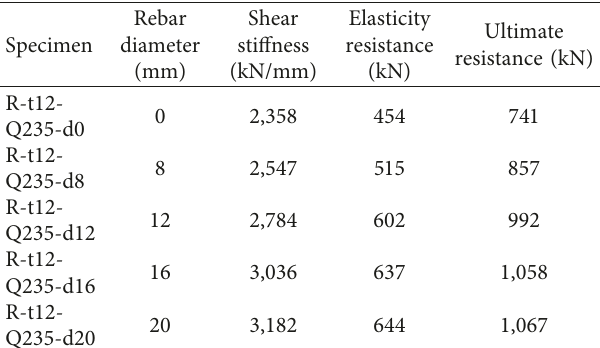
Table 4: Influence of the transverse rebar